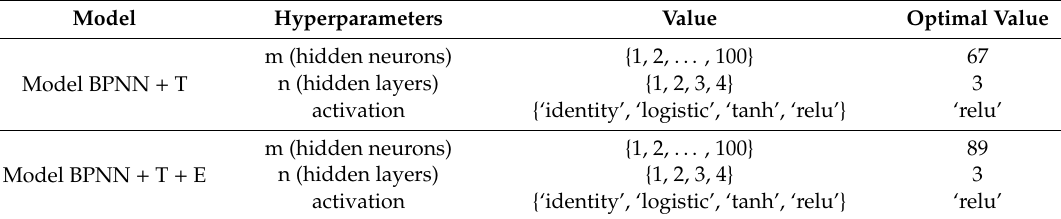
Table 7. Hyperparameter settings for the